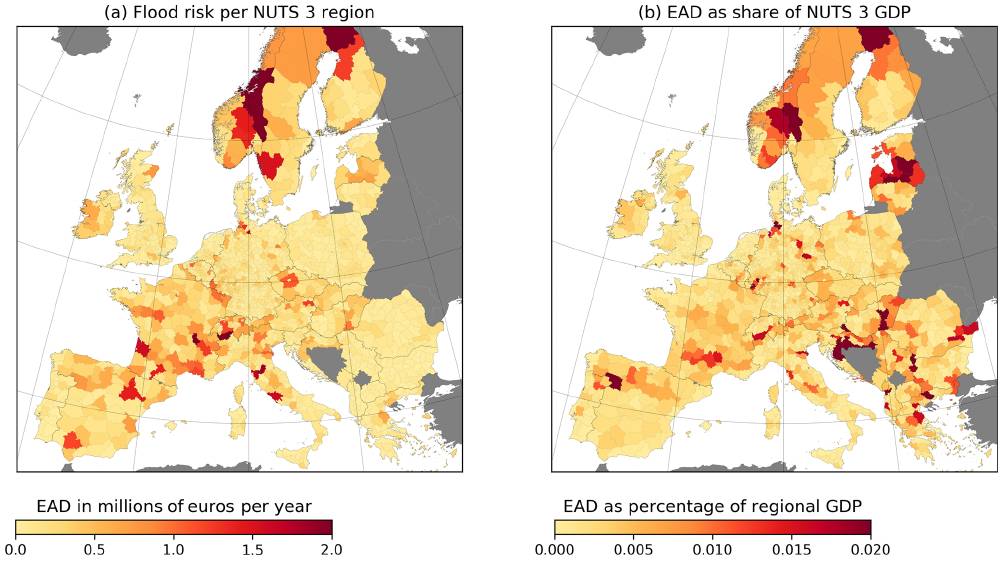
Figure 6. Expected annual damage (EAD) to road infrastructure aggregated by the NUTS 3 region. Panel (a) presents the absolute values; panel (b) expresses the EAD as a percentage of the GDP per NUTS 3